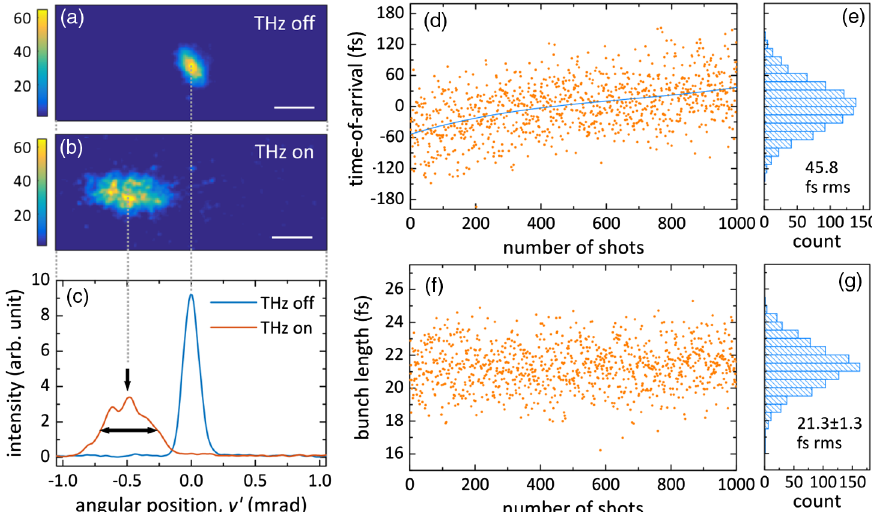
FIG. 3. Experimental data of the relative-to-laser time jitter and the bunch length of the electron beams determined from single-shot THz streaking images. From (a) – (c) the comparison of single-shot electron beams profiles with the THz off and on, one can determine the relative time-of-arrival [vertical arrow in (c)] and bunch length [horizontal arrow in (c)] of every electron pulse. (a) – (c) have same horizontal axes. The scale bars in (a) and (b) correspond to 1.0 mm on the detector screen or 0.31 mrad in divergence. (d) – (e) show the time-of-arrival of 1000 electron shots. After removing the slow timing drift, the timing stability is 45.8 fs rms. (f) – (g) show the bunch length for the same 1000 shots after deconvolution. The bunch length is 21 . 3 (cid:2) 1 . 3 fs